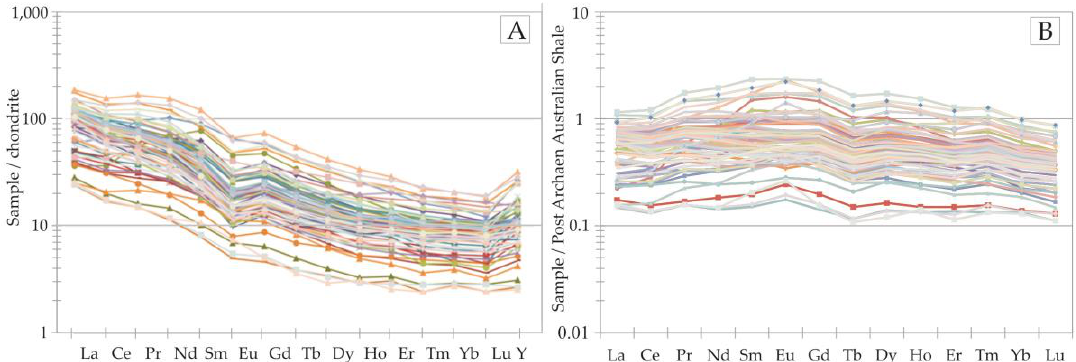
Figure 17. ( A ) REE diagrams normalized to chondrite, after [70] and ( B ) to PASS, after [79] for the Kupferschiefer Cu-Ag deposits on the Fore-Sudetic Monocline in Poland.